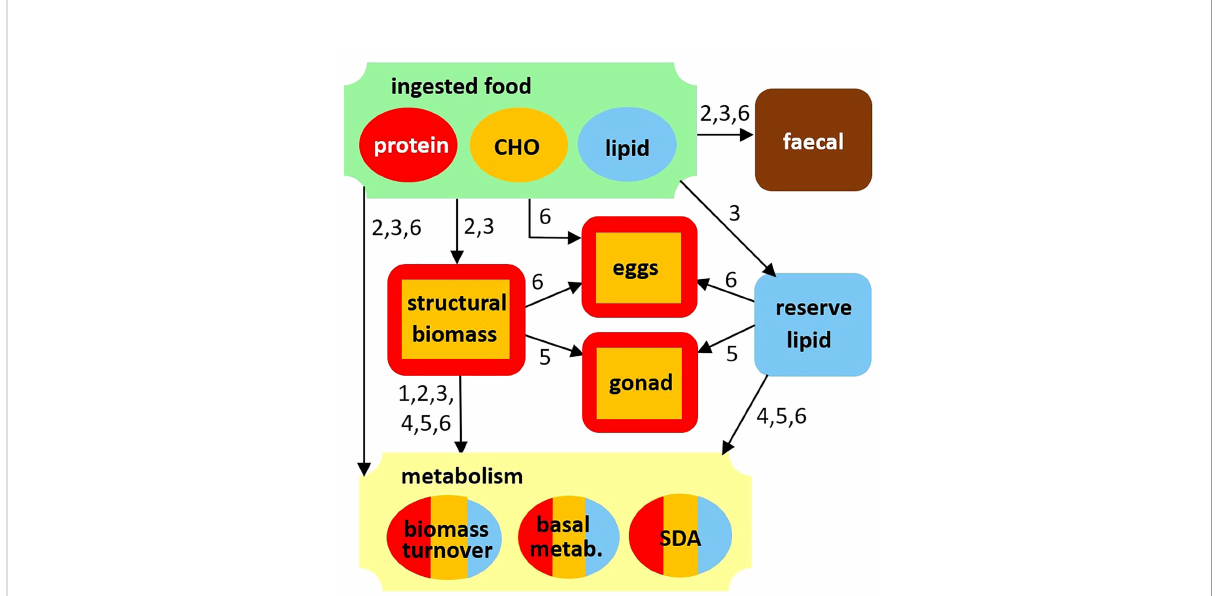
FIGURE 3 Model diagram showing use of protein (red), carbohydrate (CHO, orange) and lipid (blue) in food, as well as storage lipid and structural biomass, for growth, metabolism and egg production. Numbers refer to the Phases in which particular fl ows take